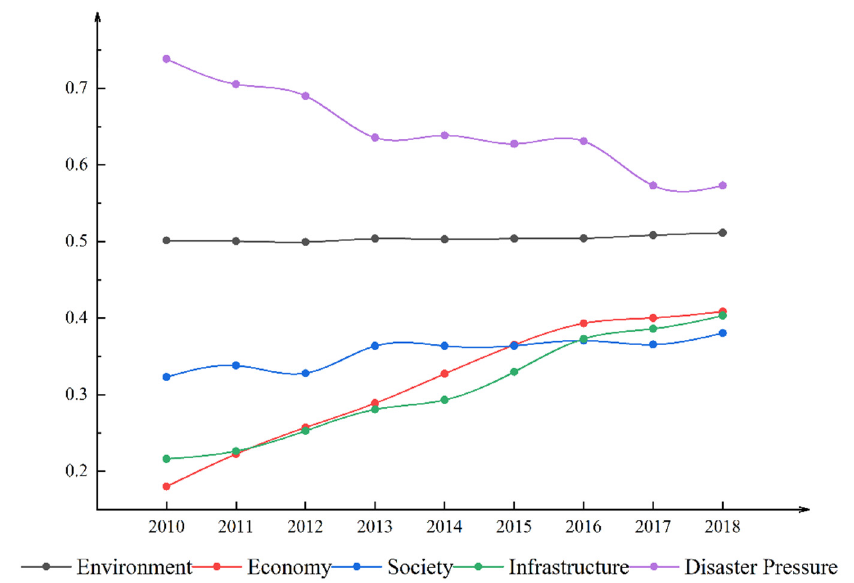
Figure 3. The quintuple structure of the disaster resilience in Aba.